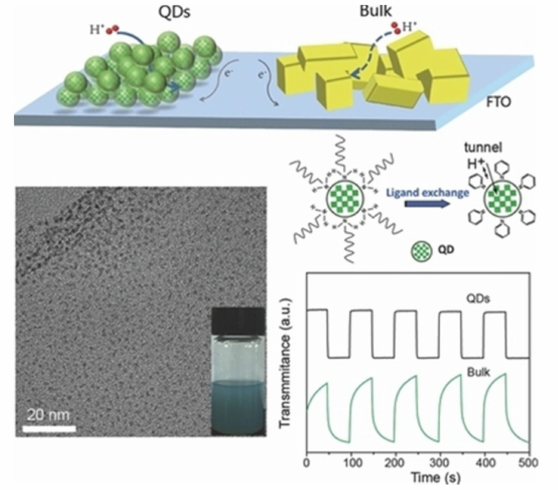
Figure 4. Comparison of bulk (green) and quantum dot (black) tungsten materials [66]. Inamdar [71] prepared oxygen-enriched nanometer tungsten oxide by adjusting mag- netron sputtering parameters. The particle size of tungsten oxide was less than 10 nm, as shown in Figure 5, and a large voltage window (1.4 V) was obtained, with a specific capac- itance of 228 F/g at 0.25 A/g, maintaining 75% of the initial capacitance for 2000 cycles, and a color rendering efficiency of 170 cm 2 /C. It was verified that oxygen-rich tungsten oxide can accelerate the modulation speed of the device, because the excess oxygen element introduces more defects into the microstructure and achieves the purpose of containing more Li+ ions. This is also similar to the reason why amorphous tungsten oxide films have faster response speed than crystalline tungsten oxide films, both of which increase the porosity of the films [72].